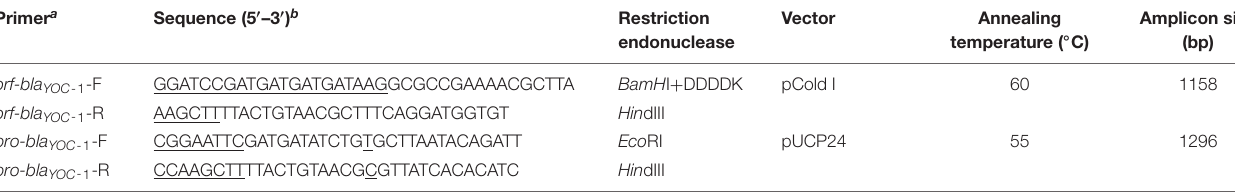
TABLE 2 | Cloning primers for the bla YOC - 1 gene. Primer a Sequence (5 (cid:48) –3 (cid:48) )